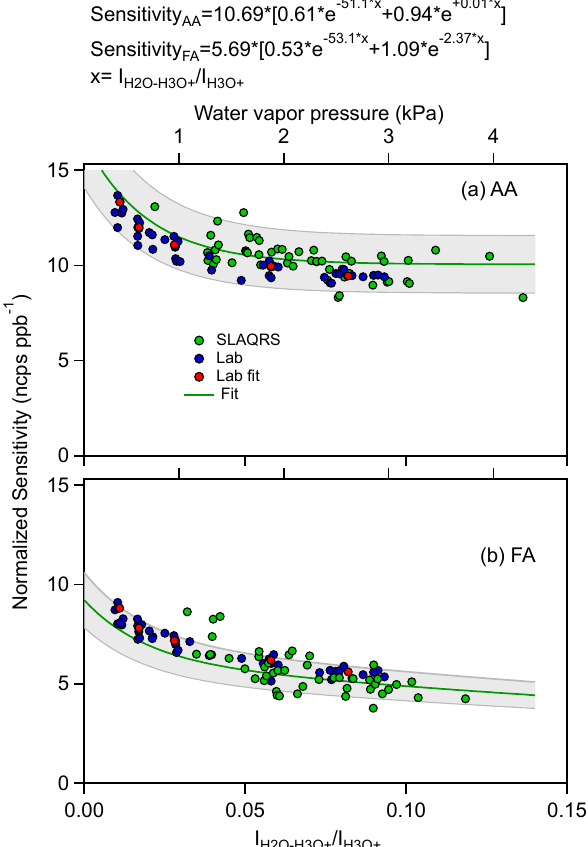
Figure 4. Humidity dependence of the PTR-MS response to (a) AA and (b) FA at E/N = 125Td. Normalized sensitivity values ob- tained in the field (SLAQRS campaign in East St. Louis, USA) and in the laboratory are shown. A double exponential fit (green lines) was used to quantify and correct for the humidity dependence of the AA and FA sensitivities. Shaded areas represent ± 15% of the fit predictions. See text for details.